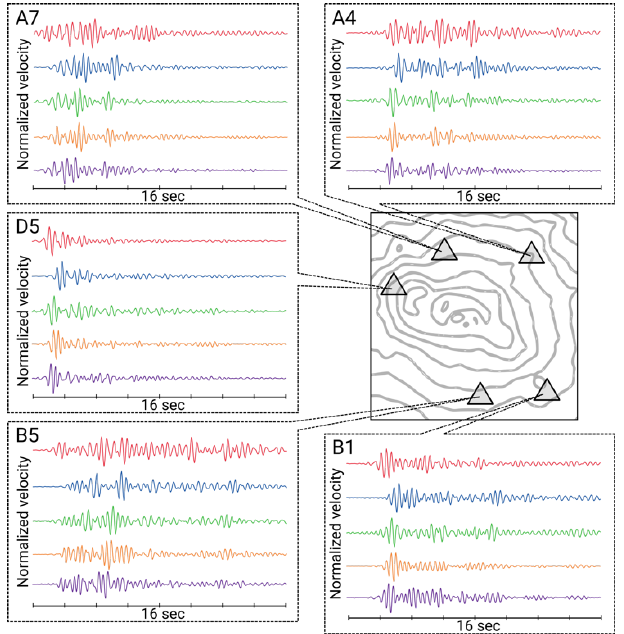
Figure 9. Template waveforms for five closest to summit stations (same colors as Figure 8).